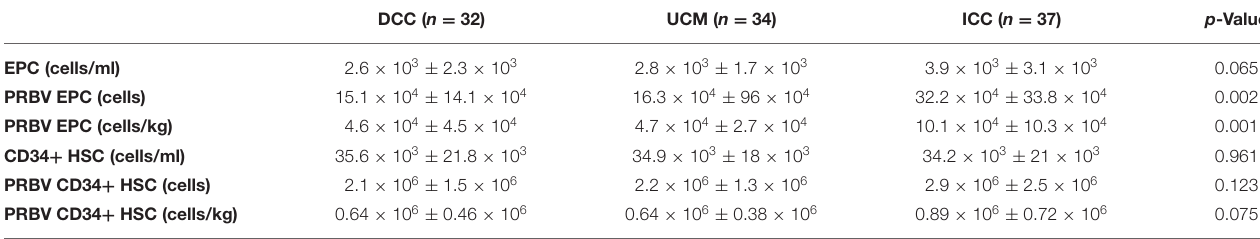
TABLE 2 | The numbers of endothelial progenitor cells (EPCs) and CD34 + hematopoietic stem cells (HSCs) following cord management.